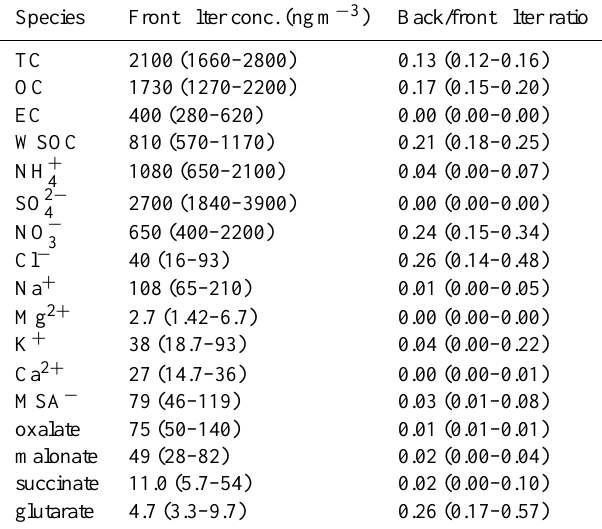
Table 1. Front filter median concentrations and interquartile ranges (inngm − 3 ) of TC (=OC+EC), OC, EC, WSOC, low-MW dicar- boxylic acids and selected inorganic species for the PM 2 . 5 size fraction of the HVDS samples. Also given are the medians and interquartile ranges for the back/front filter ratio of the various